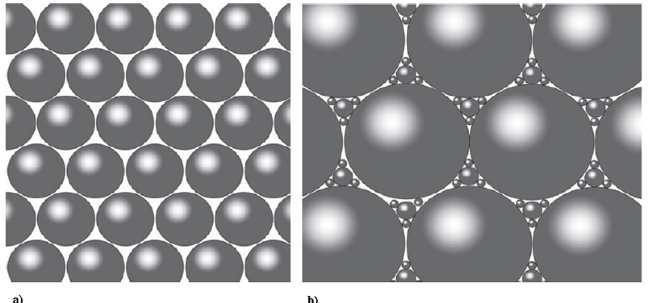
Figure 1. ( a ) Packing density of a single size system. ( b ) Increased packing density of a system using